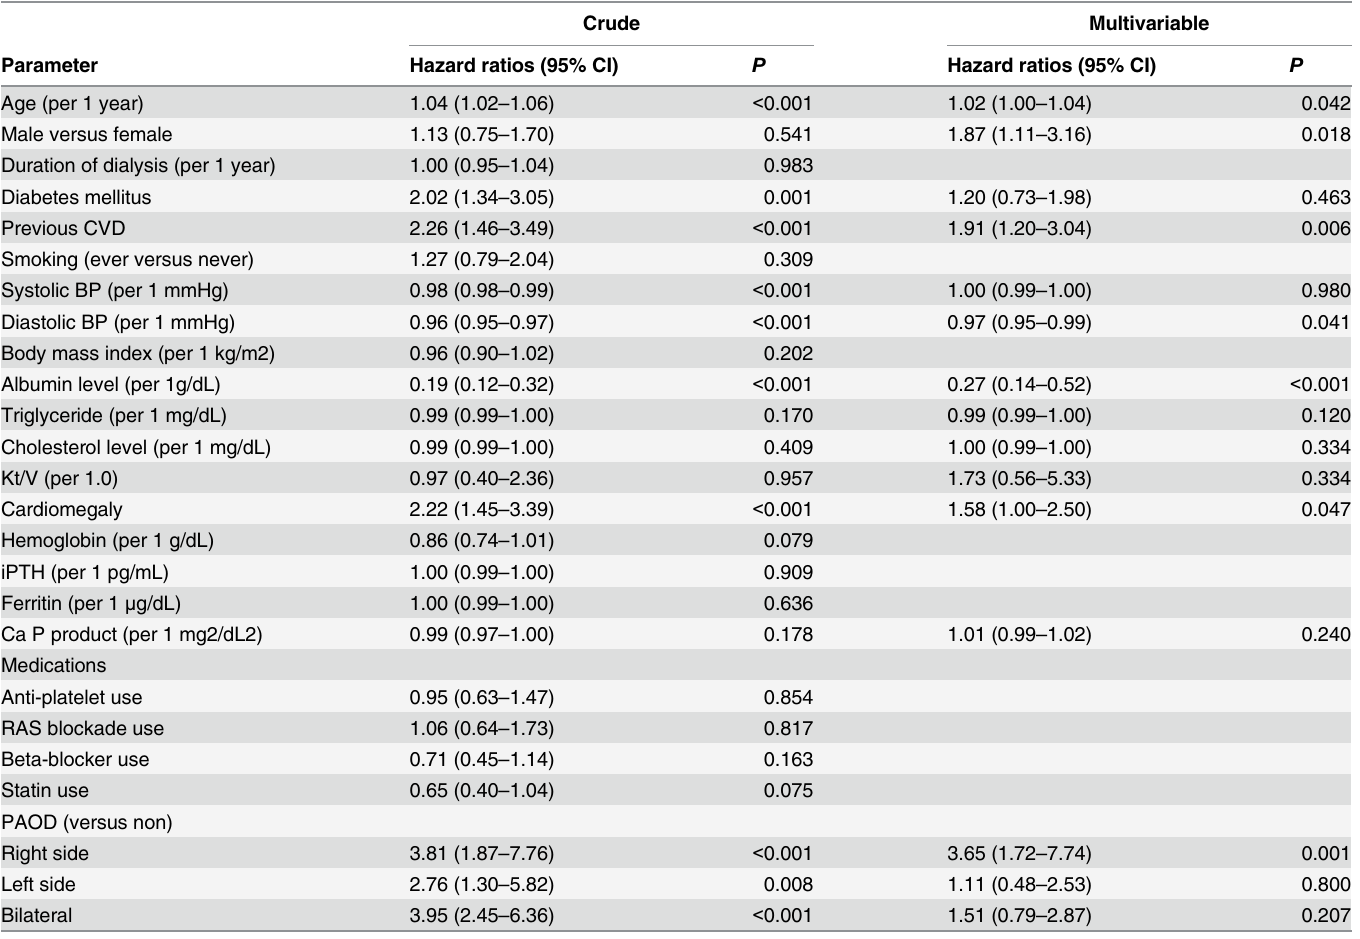
Table 4. Cox proportional hazards regression analysis for cardiovascular mortality.